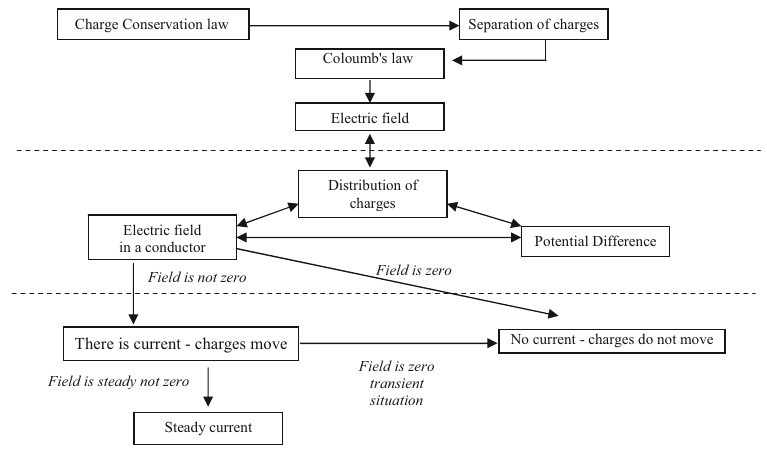
FIG. 2. The concept map and list of new goals, presented by the “From electrostatics to currents” group in conference I. This concept map has three main components (cid:1) separated by the two dashed lines (cid:2) : some concepts of electrostat- ics, some concepts of electric circuits, and an in- terface relating the two, defined by the teachers as the new target of